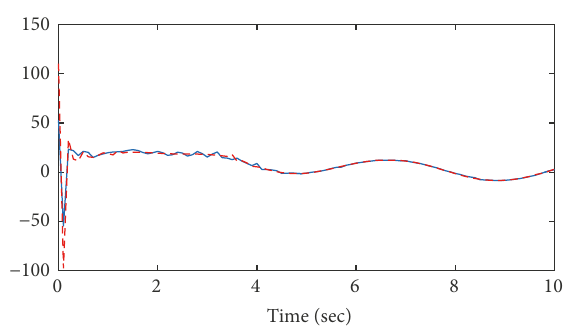
Figure 7: Control input: LC (-) and ANC (-